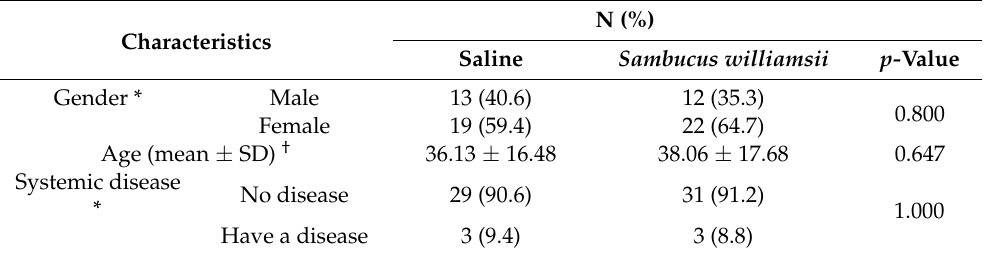
Table 2. Characteristics of